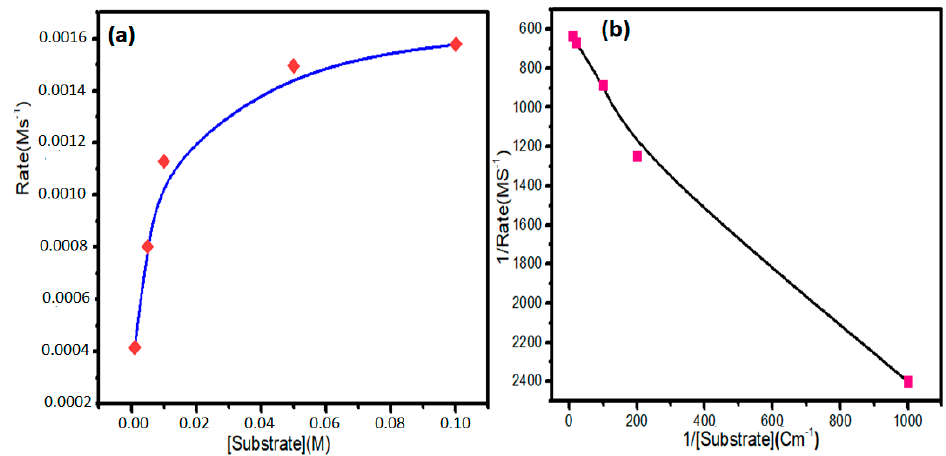
Figure 9. ( a ) Oxidation reaction initial rates vs. 3,5-DBT conc., and ( b ) the Lineweaver–Burk plots.